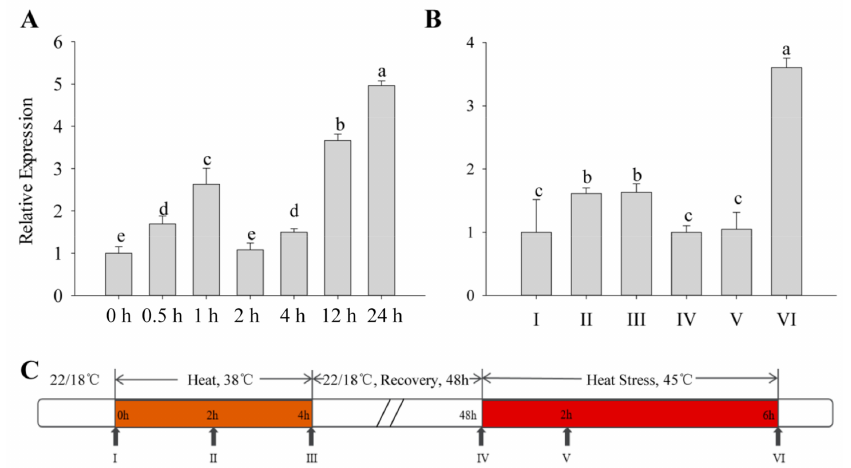
Figure 2. Analysis of the change in CaFtsH06 expression in pepper plants under heat stress. ( A ) Detection of background heat tolerance of CaFtsH06 in pepper. ( B ) Detection of acquired heat tolerance associated with CaFtsH06 in pepper. ( C ) A time course of high temperature treatment and normal temperature recovery, with the arrows indicating the time points at which pepper leaves were collected (samples I–VI). Different letters denote statistical significance ( p < 0.05).